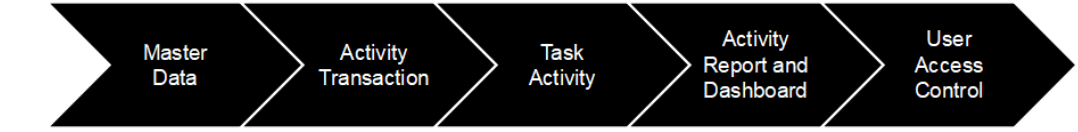
Figure 3. Development Iteration Table 1. Mapping of